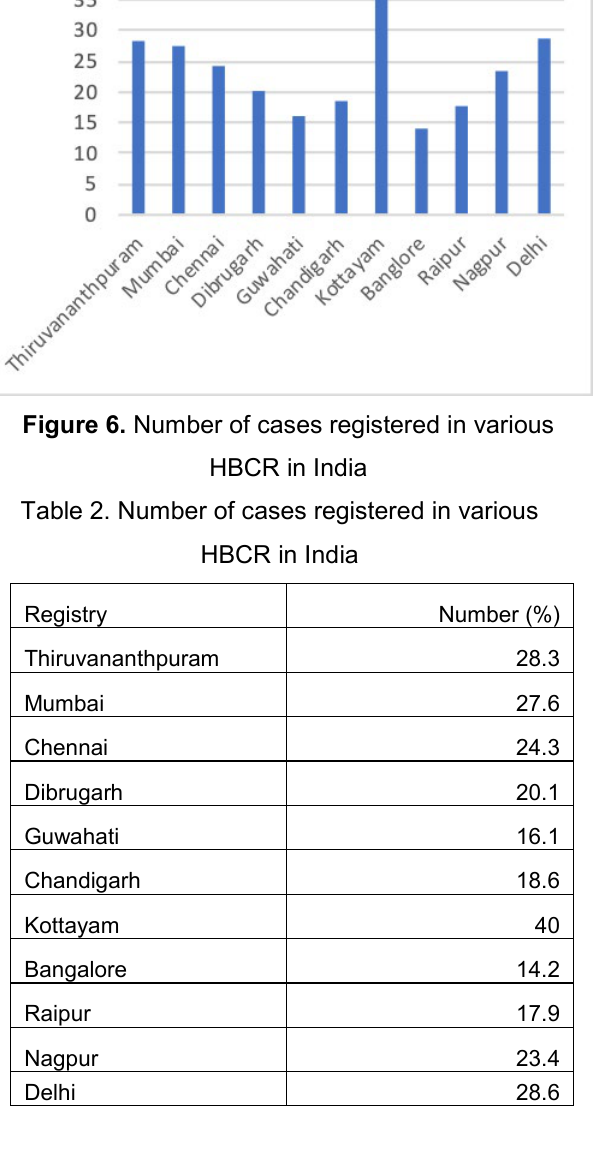
Figure 7. Age wise Group